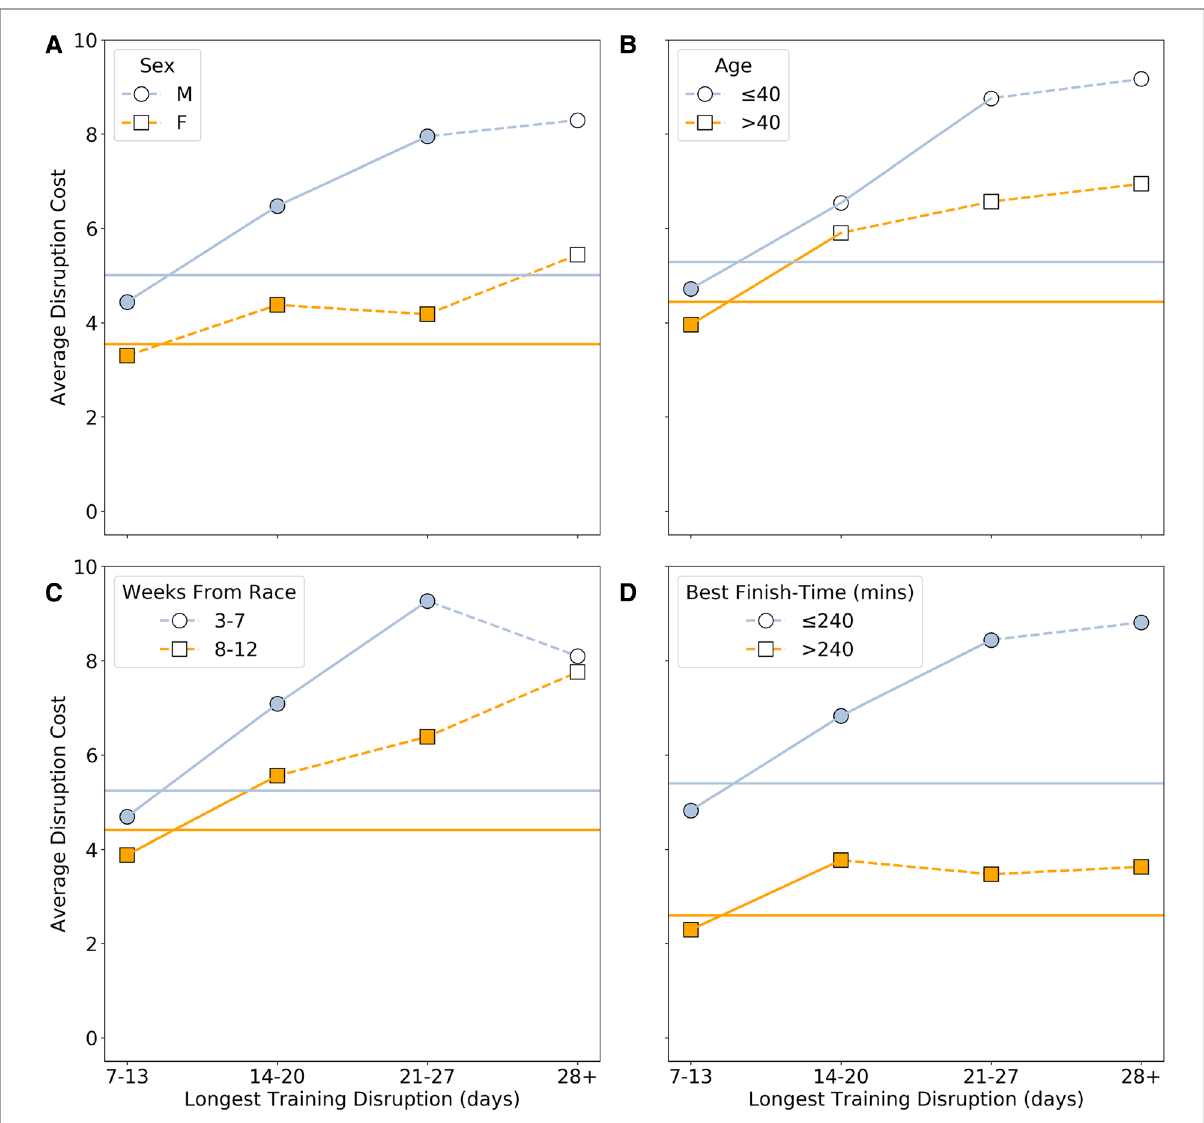
FIGURE 3 The average disruption cost based on: ( A ) sex (male versus female); ( B ) age ( (cid:2) 40 years-old vs >40 years-old); ( C ) timing (early or late in training); and ( D ) runner ability (based on whether their fastest marathon was faster, (cid:2) 240min, or slower, (cid:5) 240min). Statistical signi fi cance between groups, for a given disruption duration, is calculated based on a t -test with p , 0 : 01 and indicated by fi lled ( p , 0 : 01) or un fi lled ( p (cid:5) 0 : 01) markers. The within- group statistical signi fi cance of differences between consecutive disruption durations is calculated using a t -test with p , 0 : 01 and indicated by solid ( p , 0 : 01) or dashed ( p (cid:5) 0 : 01) connecting lines. The horizontal lines indicate the mean values for each pair of groups; if the difference between the overall means is signi fi cant then the lines are solid otherwise they are dashed.